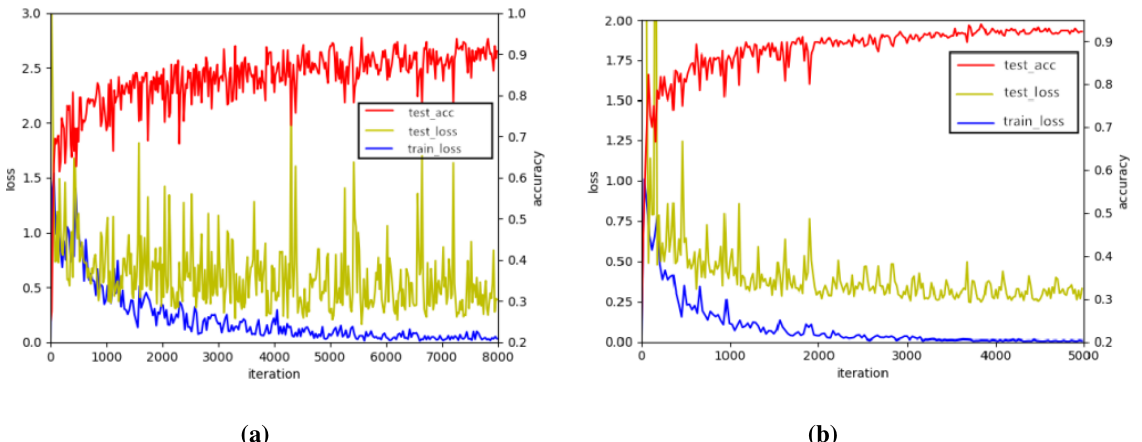
Fig. 9 The training and testing results of the ResNet model. (a) Dataset 1 and (b) Dataset 2.